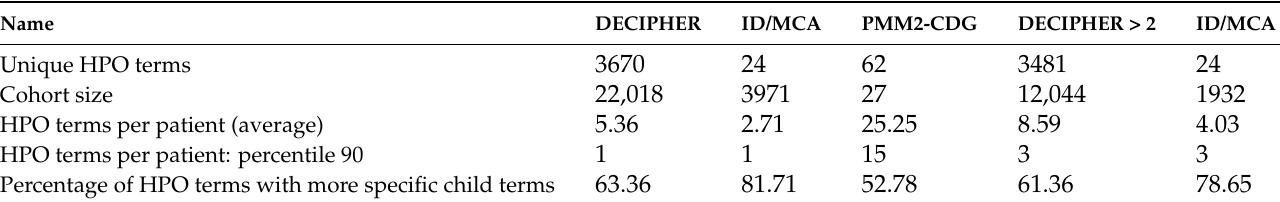
Table 3. Cohort Analyzer general summary statistics. Results for the datasets following filtering to remove patients with less than three assigned HPO terms are indicated with >